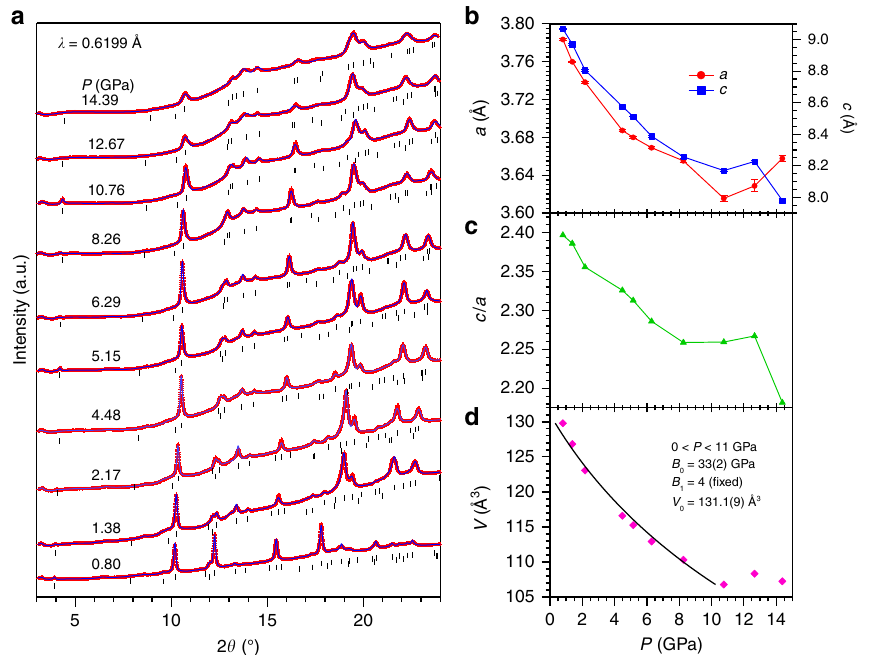
Fig. 4 High-pressure synchrotron X-ray diffraction. a SXRD patterns of (Li 1 − x Fe x )OHFe 1 − y Se fi tted with LeBail method. The fi rst and second rows of tick marks in a represent the Bragg positions of the tetragonal P4 / nmm phase of (Li 1 − x Fe x )OHFe 1 − y Se and the secondary phase Se with space group P3 1 21 . b – d Pressure dependence of unit-cell parameters a , c , V , and the c / a ratio. The solid line in d is the Birch – Murnaghan fi tting curve used to extract the bulk modulus given in the